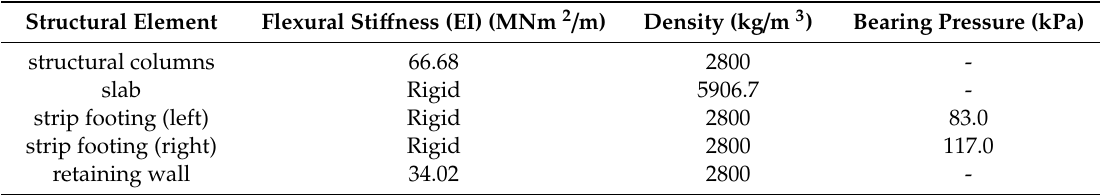
Table 1. Structural properties.